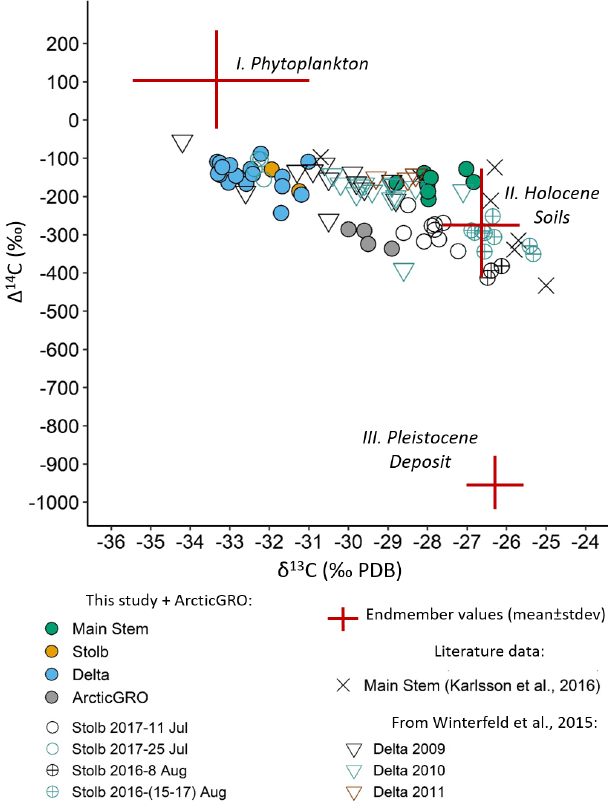
Figure 4. The origin of the POC in the Lena River and the Lena delta. Endmember values (red crosses) were combined after Gal- imov et al. (2006), Wild et al. (2019), and Winterfeld et al. (2015); additional previously published data were added from Winterfeld et al. (2015) and Karlsson et al.